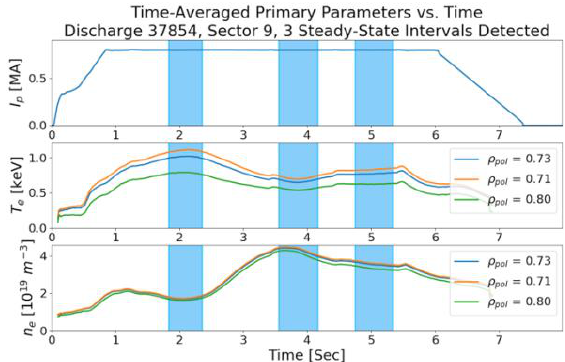
Fig. 1. Time intervals for the analysis of CECE data are selected based on the degree to which the local electron temperature and density are in steady-state at each CECE measurement location within the plasma current flat-top period. The curves shown for the electron temperature and density are evaluated at three radial positions: the radially innermost, middle, and outmost CECE measurement locations for this